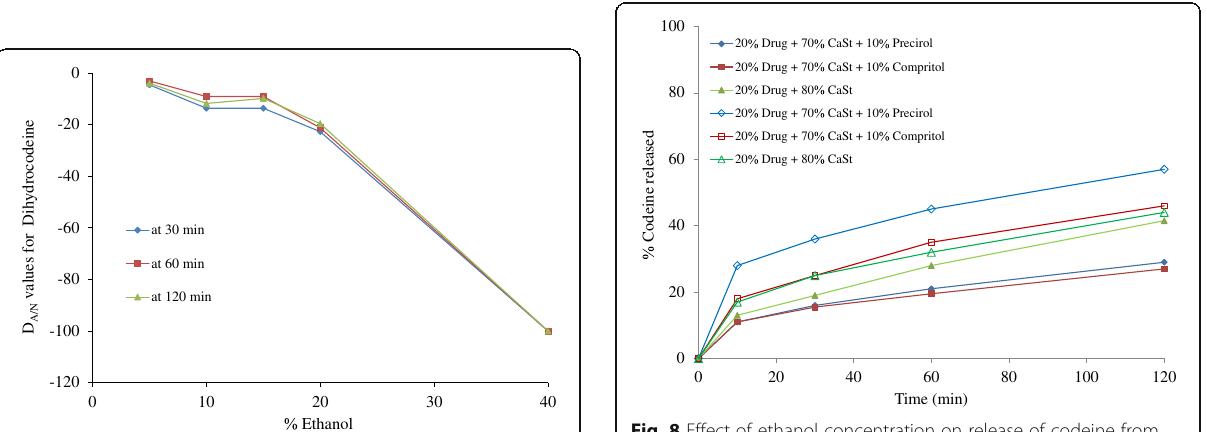
Fig. 8 Effect of ethanol concentration on release of codeine from hot melt extruded pellets (closed legends = 0% ethanol, open legends = 40% ethanol) (data from reference (Jedinger et al.